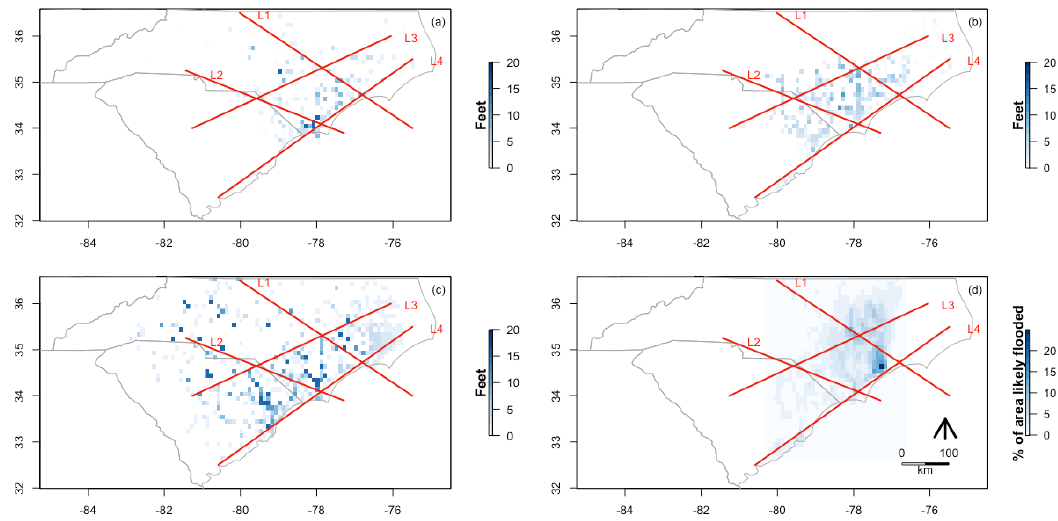
Figure 7. Cross-section line locations overlaid on flood sources ( a ) crowdsourced image derived flood depth, ( b ) USGS HWM and Gage Peak, ( c ) RIFT flood model, and ( d ) ARIA % of area likely